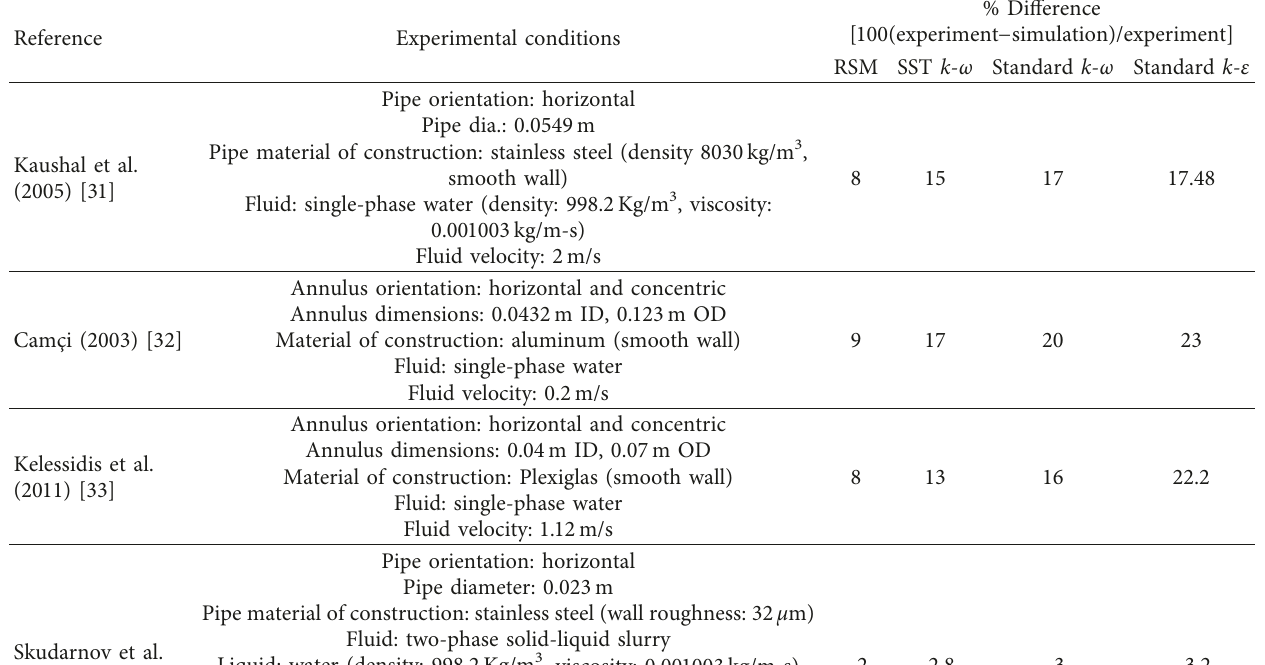
Table 1: Analysis of turbulence model performance.